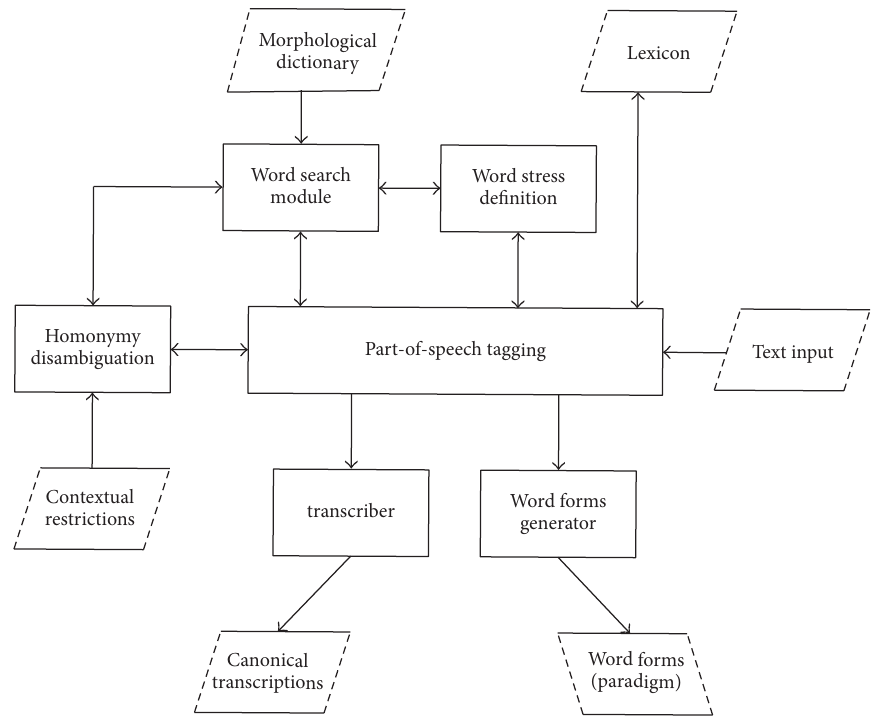
Figure 1: Linguistic